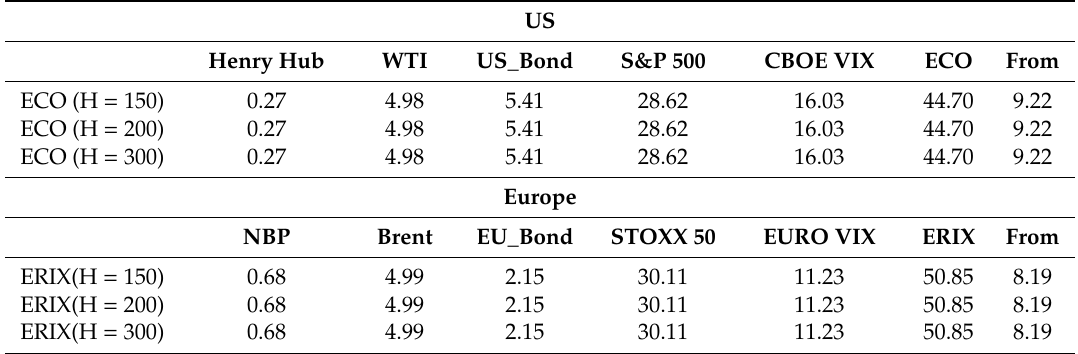
Table A1. Return spillover results under the di ff erent forecast horizons.